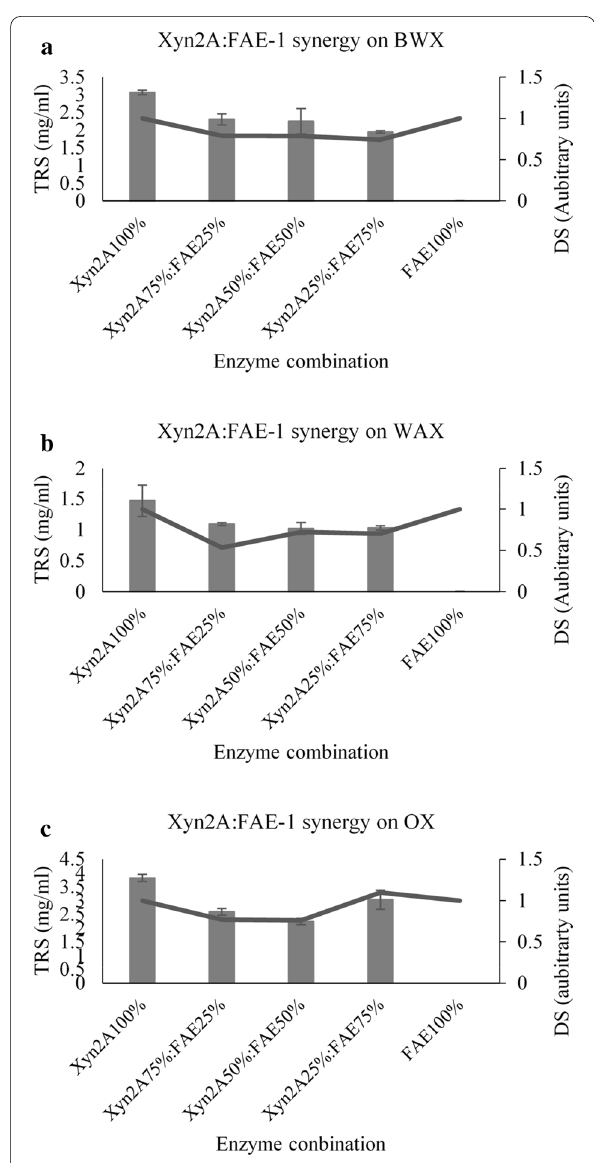
Fig. 5 Synergistic hydrolytic activities of the GH11 xylanase (Xyn10D) and feruloyl esterase (FAE-1) on beechwood xylan ( a ), insoluble wheat arabinoxylan ( b ) and oat spelt xylan ( c ). The TRS represent the amount of released total reducing sugars from xylan and DS represents the degree of synergy formed between two enzymes. ANOVA analysis indicated the improvement of reducing sugar release by the enzyme combinations compared to lone enzyme protein loading, keys: *(p value < 0.05) and #(p value < 0.01). Values are represented as mean values SD (n ± =